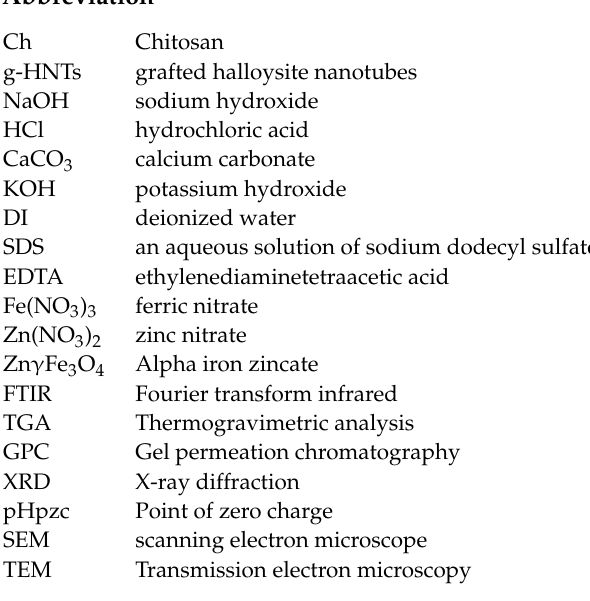
Figure S4: Thermodynamic adsorption parameters for the adsorption of (a) Cr (III), (b) Fe (III),